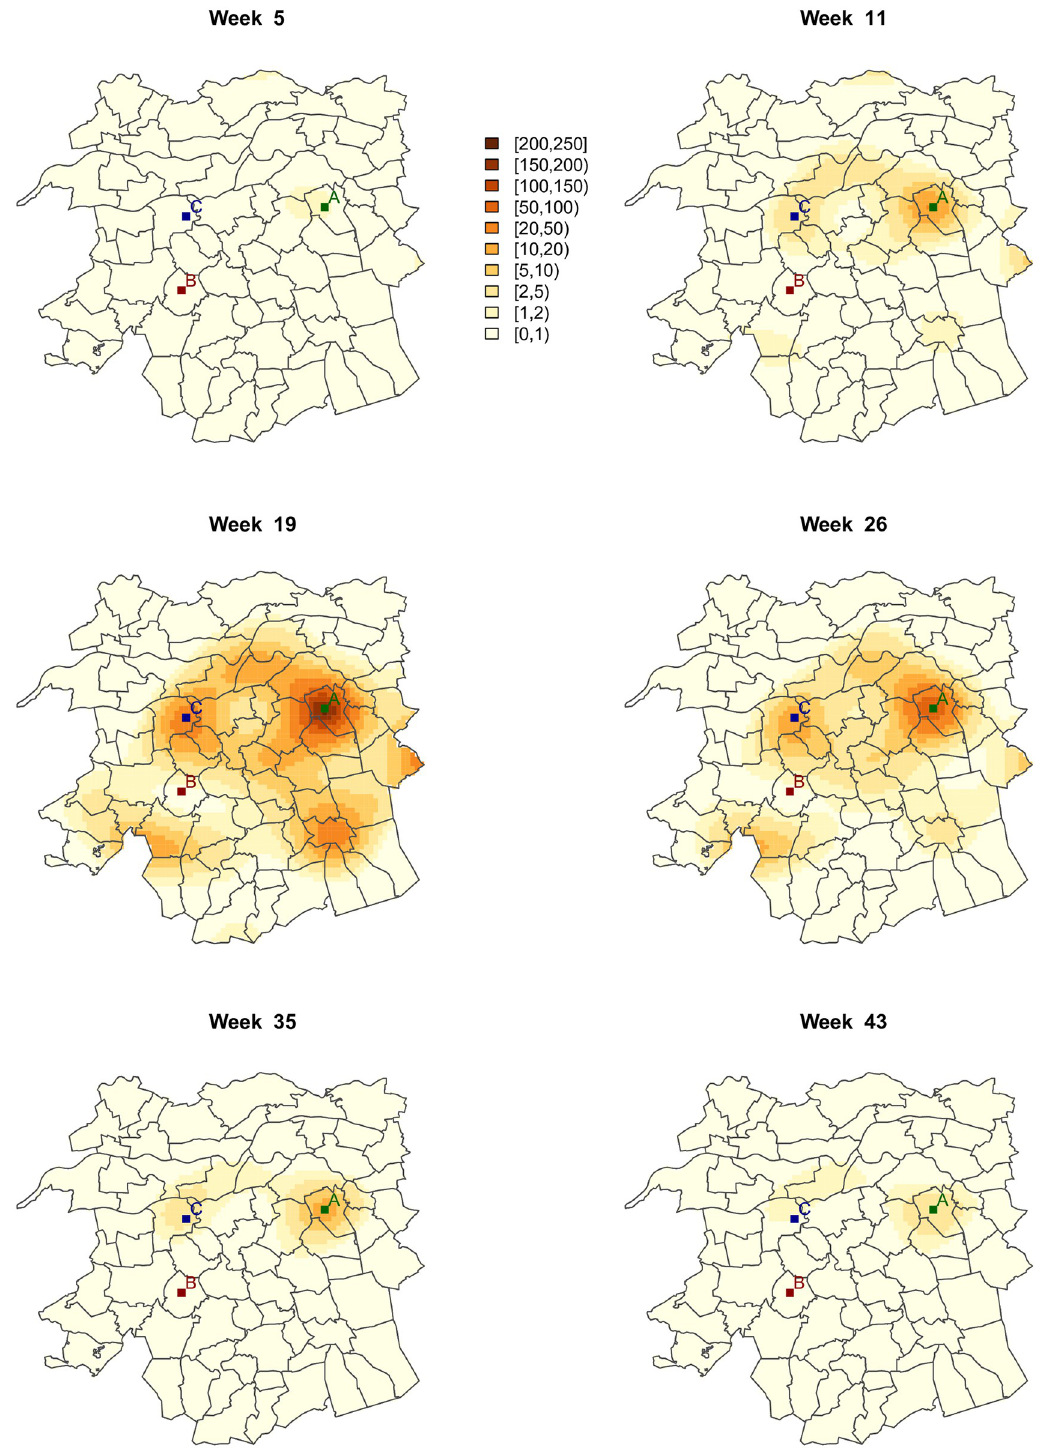
Fig 4. Smoothed Q fever incidence at a detailed spatio-temporal scale, resulting from the ST-PCLM approach, for six selected weeks.